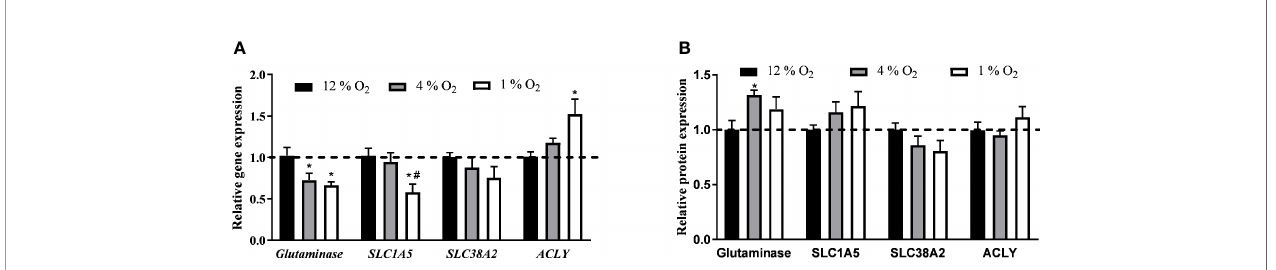
FIGURE 5 | The Effect of Hypoxia on Expression of Genes and Proteins Involved in Glutamine Transport and Lipid Synthesis. The effect of hypoxia on gene (A) and protein (B) expression. Differentiated L6 myotubes were exposed to hypoxia for 7 days and gene and protein expression analysis was quanti fi ed. *p < 0.05 for comparison with control exposures (12% O 2 , ANOVA, N = 6), # p < 0.05 for comparison with 4% O 2 exposures (ANOVA, N =